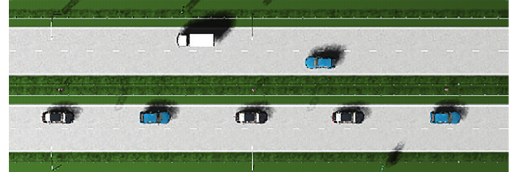
Figure 8: Test scenario for the mixed